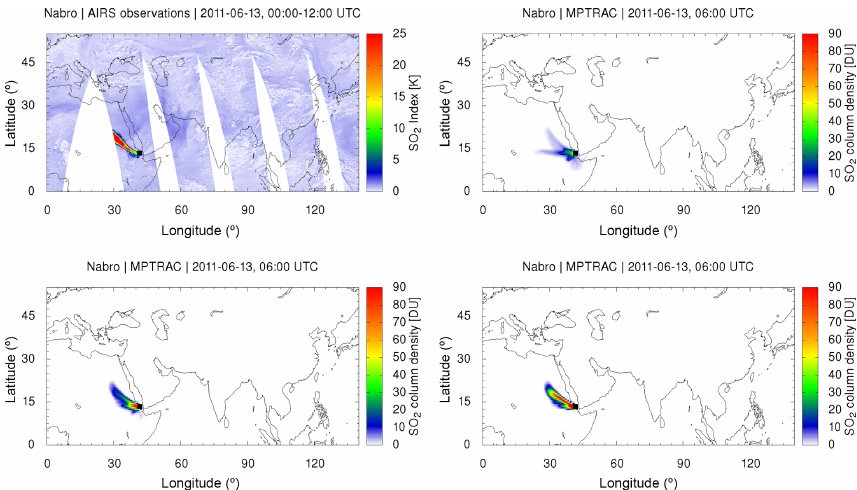
Figure 11. Comparison of AIRS satellite observations (top, left) and MPTRAC simulation results on 13 June 2011, 06:00UTC based on the equal-probability strategy (top, right), the mean rule (bottom, left), and the product rule (bottom, right).